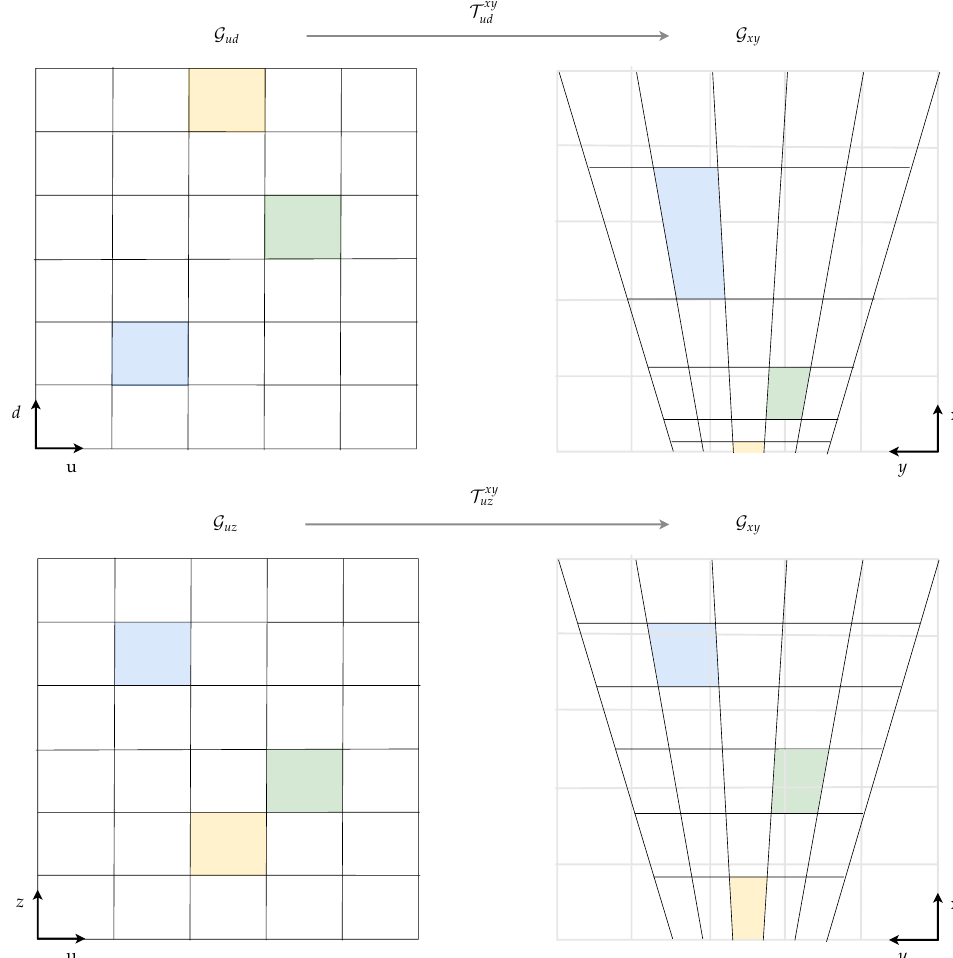
Figure 5. In the cartesian grid on the right-hand side, the grid cells are influenced by the distorted overlayed areas based on the corresponding u-disparity or u-depth grid cell,